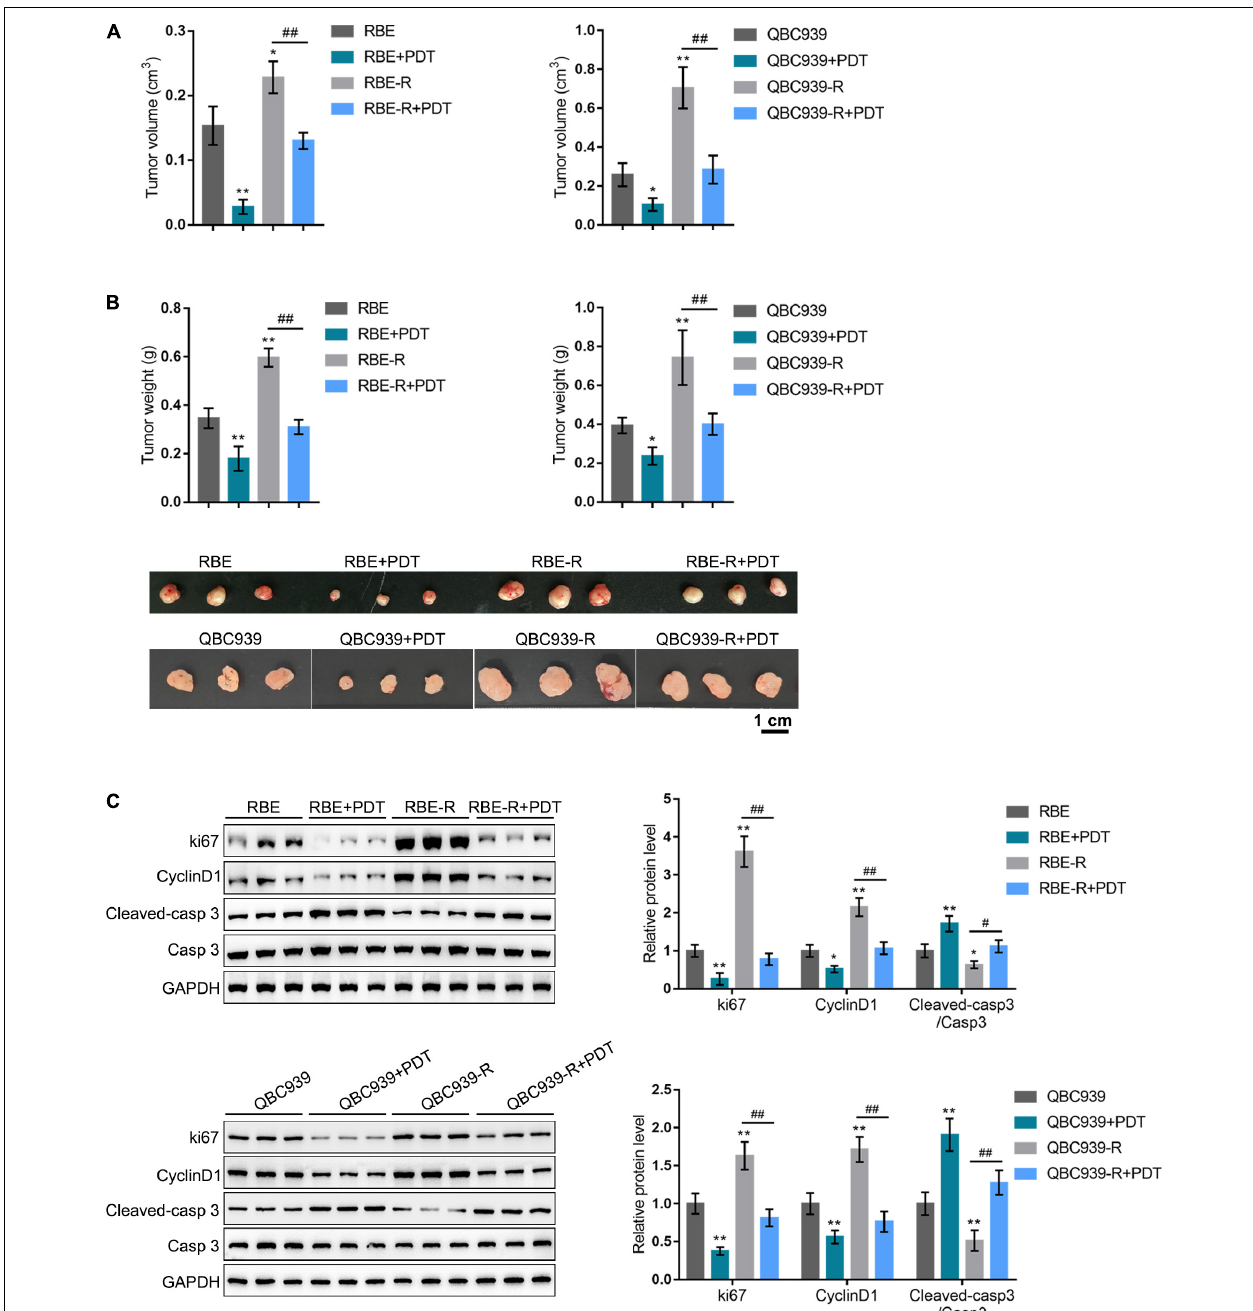
FIGURE 2 | PDT treatment inhibits gemcitabine-resistant cholangiocarcinoma cells xenotransplanted tumors. (A,B) Xenotransplanted tumor model derived from regular RBE and QBC939 or gemcitabine-resistant RBE-R and QBC939-R cells was established in nude mice as described in section “Materials and Methods.” Twenty-eight days after transplanting, the tumors were undergone PDT treatment. Fourteen days later, the tumor size was measured and the tumor volume was calculated (A) ; the tumor weight was measured (B) ; (C) the protein levels of ki67, Cyclin D1, cleaved-caspase 3, and caspase 3 in tumor tissues were examined by Immunoblotting. * P < 0.05, ** P < 0.01, ## P < 0.01.